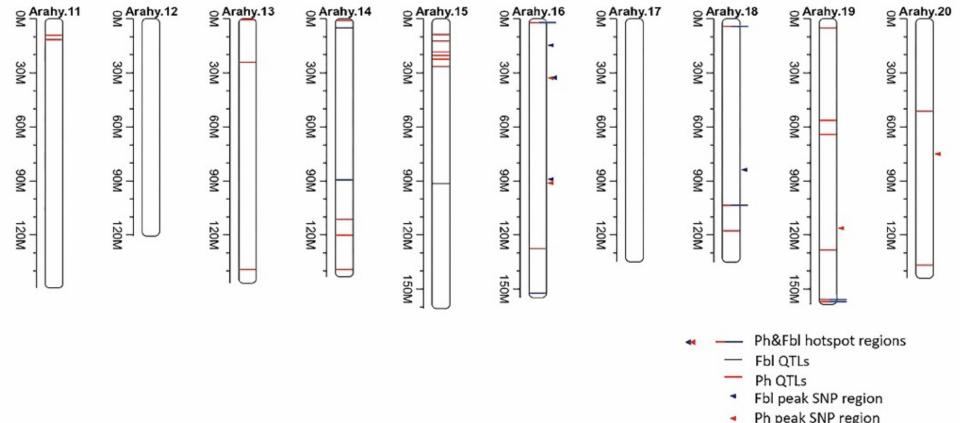
Figure 2. Quantitative trait loci (QTLs) identified to be associated with Ph and/or Fbl by both this and earlier studies. The blue lines represent the QTLs for Fbl identified from earlier studies while red for Ph. The solid triangles point to the peak SNP regions that are identified to be associated with Ph (red) and/or Fbl by the present GWAS